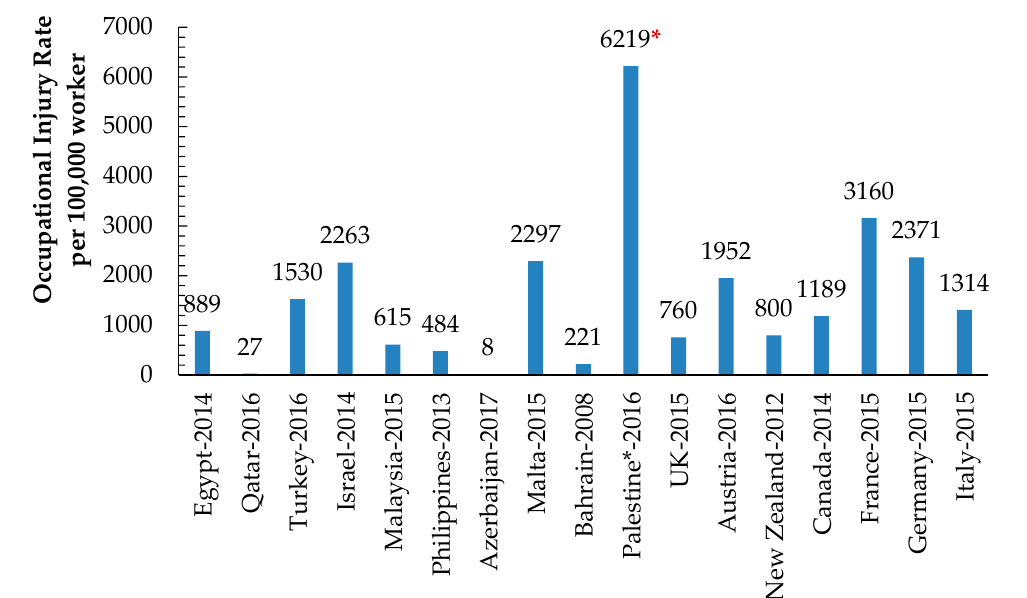
Figure 12. The Occupational Injury Rate (per 100,000 workers) in Palestinian manufacturing industries compared to those of other international countries. * The Calculated IR of 2016 obtained OSH statistics for the Palestinian industrial establishments.